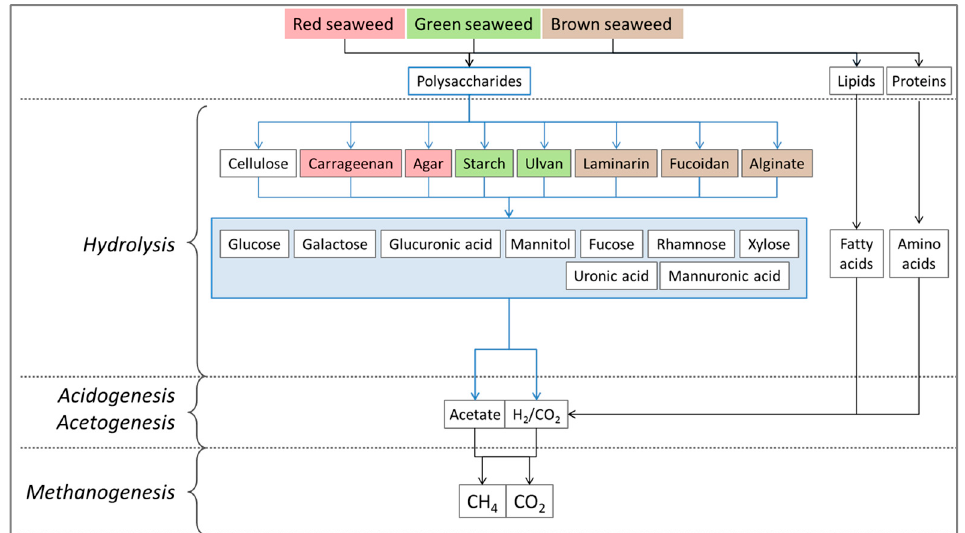
Figure 1. Major steps for biogas production. Cellulose, lipids, and proteins are generally found in all seaweeds. Laminarin, fucoidan, and alginate are typical of brown seaweed (colour-coded brown). Starch and ulvan are typical of green seaweeds (colour-coded green), and the polymeric polysaccharides carrageenan and agar are characteristic of red seaweeds (colour-coded red) [42] .